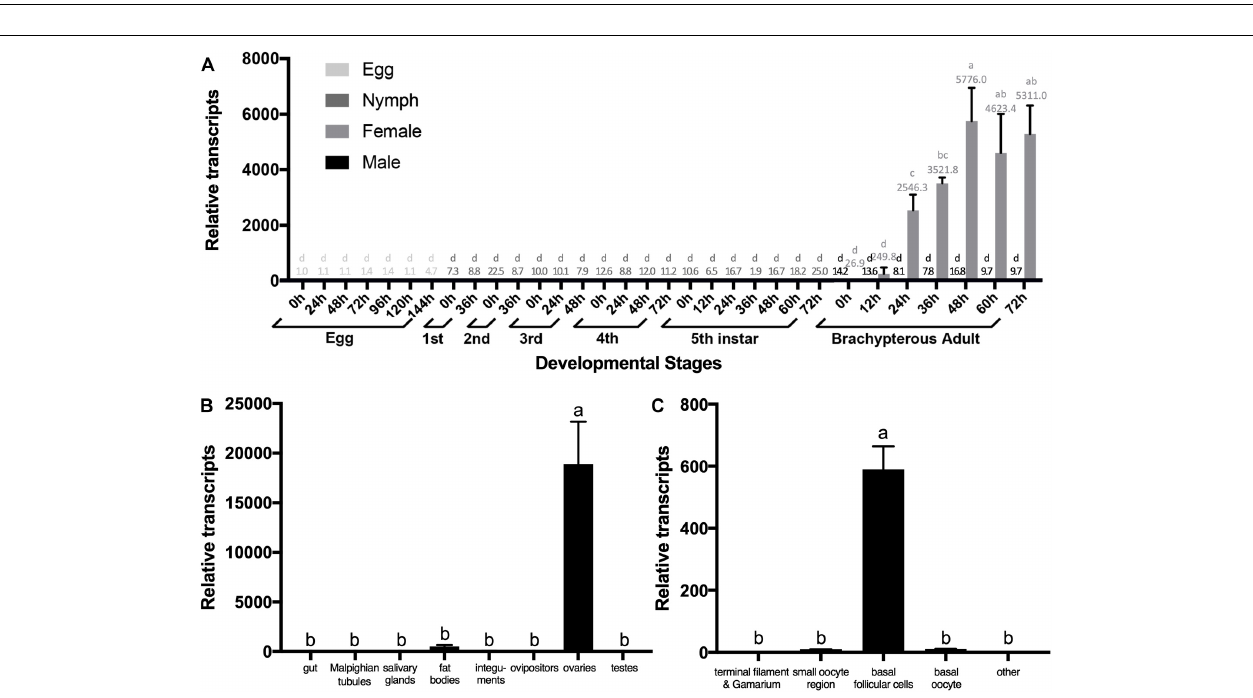
FIGURE 1 | Schematic of NlESMuc protein sequence. The polypeptide is drawn to scale and key features are indicated. TSP-rich region, threonine/serine/proline-rich region. aa, amino acids.